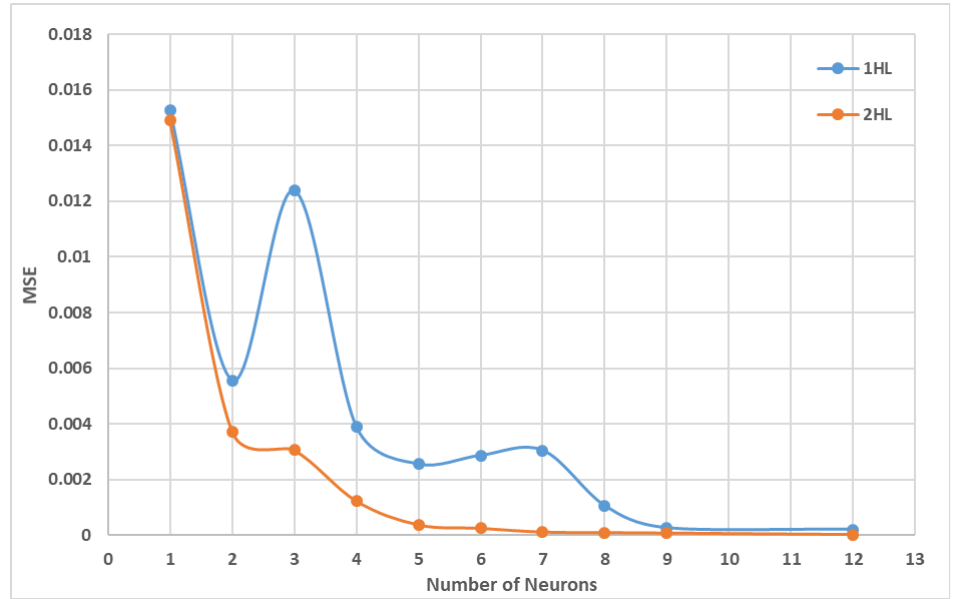
Figure 4. Comparison of 3 ANN backpropagation algorithms. ( a ) MSE of three different architec- tures with one hidden layer. ( b ) MSE of 3 ANN architectures with two hidden layers.